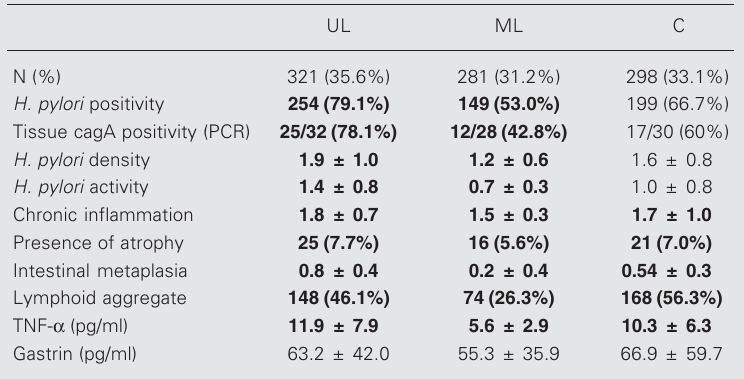
Staging for H. pylori density, activity, chronic inflammation, and intestinal metaplasia was graded as absent, mild, moderate, and significant. Data written in bold were significantly different from the others (Kolmogorov-Smirnov test and analysis of vari- ance). UL: ulcer-like dyspepsia; ML: motility disorder-like dyspepsia; C: combination of both